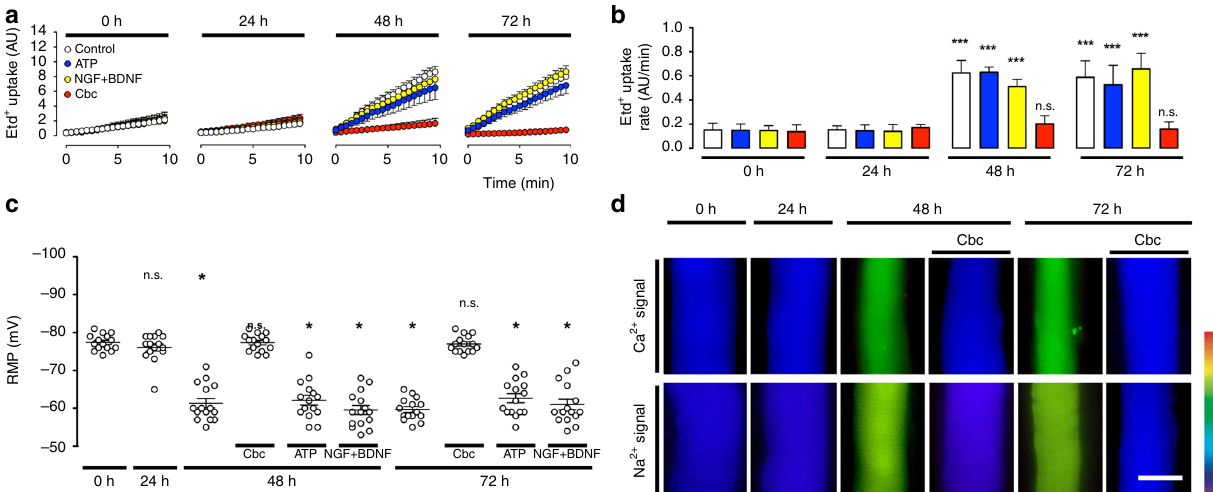
Fig. 2 Acetylcholine analog prevents cellular alterations in cultured myo fi bers. Primary cultures of myo fi bers from fl exor digitorum brevis (FDB) muscles were used. a The permeability of the sarcolemma was measured in time-lapse experiments of ethidium (Etd + ) uptake performed after 0, 24, 48, and 72 h of culture. Myo fi bers were cultured under control conditions (white), or treated with 500 µ M ATP (blue) or 50 ng/mL + NGF/50 ng/mL BDNF (NGF + BDNF; yellow), or 200 nM Cbc (red). b Etd + uptake rate of myo fi bers. N = 4 independent experiments; six myo fi bers were recorded in each experiment, each value is the mean ± SEM. *** p < 0.001 compared with myo fi bers at 0 h of culture; n.s. non-signi fi cant difference, by ANOVA with Bonferroni post hoc test. c Resting membrane potential (RMP) was evaluated at 0, 24, 48, and 72 h of culture. Myo fi bers were cultured under control conditions, or treated with ATP, NGF/BDNF, or Cbc. N = 5 independent experiments with at least twenty myo fi bers recorded in each independent experiment. * p < 0.05, compared with myo fi bers at 0 h of culture by ANOVA with Bonferroni post hoc test. d Upper panel, intracellular Ca 2 + signal (340/ 380), lower panel, intracellular Na + signal was recorded at 0 and 48 h of culture using FURA-2 or SBFI, respectively. The colored scale to the right of the panels depicts the color shifts from blue to green as the dye is bound to Ca 2 + or Na + . Parallel cultures were treated at time 0 with 200 nM carbachol (Cbc) and 48 h later the Ca 2 + and Na + signal was evaluated . Scale bar: 50 µ